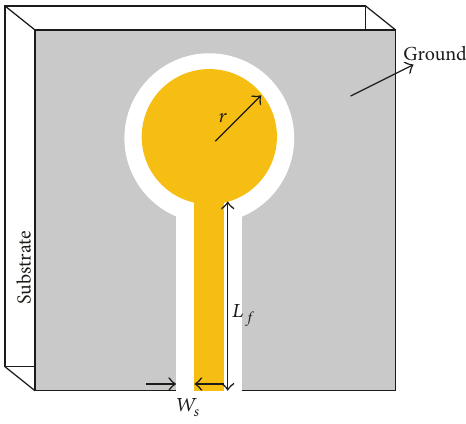
Figure 9: Geometry of the CPW antenna.